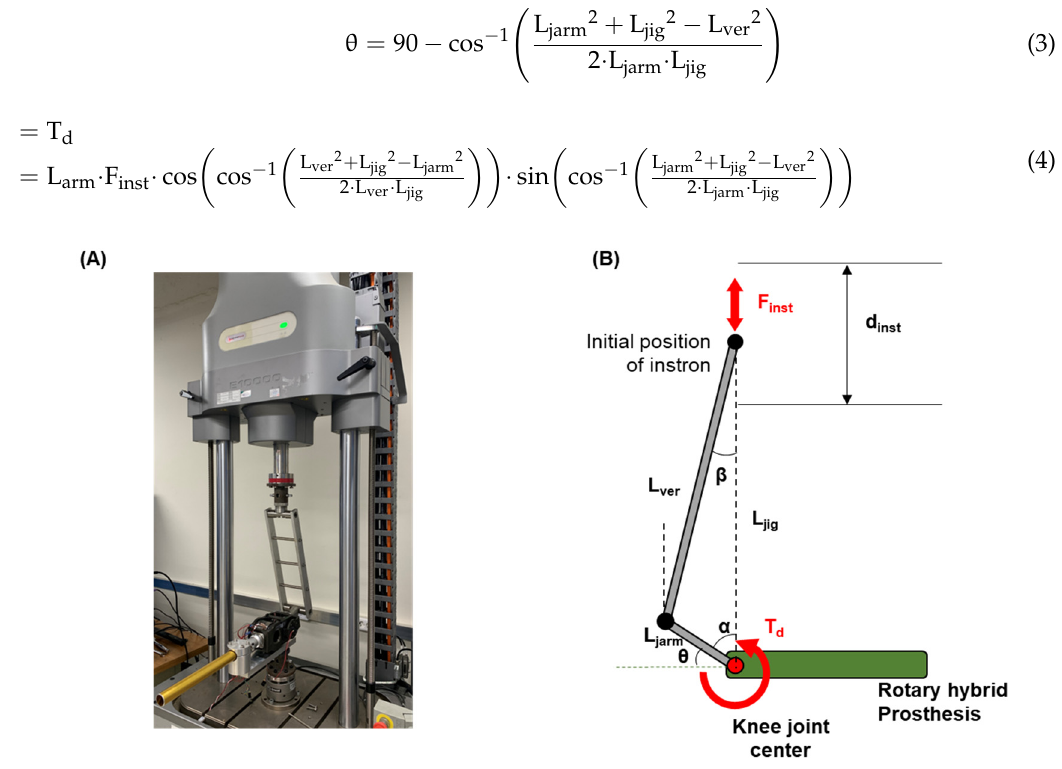
Figure 9. ( A ) Measurement test environment of damping torque; ( B ) calculating damping torque through Instron force and displacement measurement. Table 2. Parameters for damping torque calculation model.